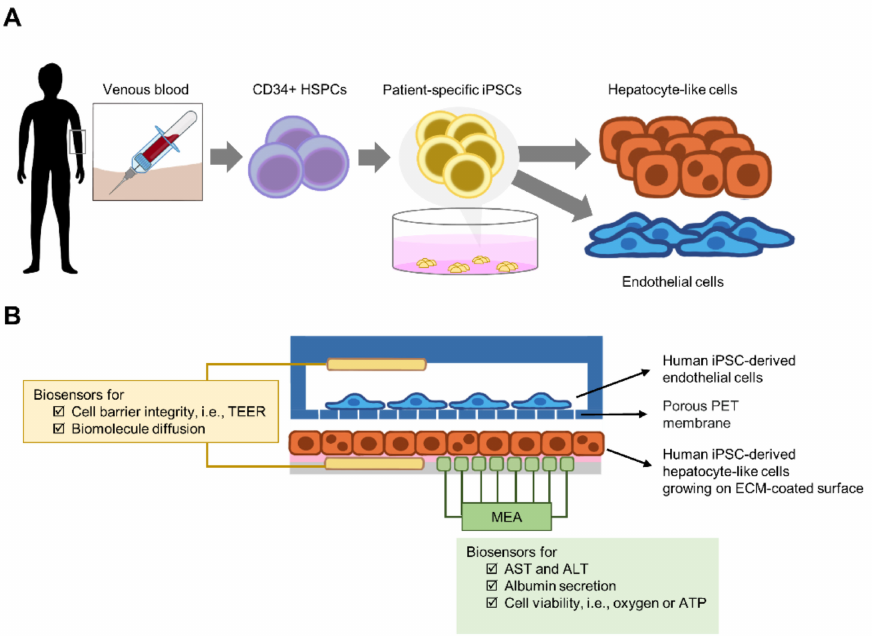
Figure 5. Proposed model for a liver-on-a-chip integrated with a biosensor. ( A ) Collection of CD34+ HSPCs from peripheral venous blood is less invasive than skin biopsy. The use of patient-specific iPS cells is a promising approach to generate individualized hepatocytes and endothelial cells. Moreover, the expandability of iPSCs provides an unlimited supply of patient-specific cells of interest for the liver-on-a-chip. ( B ) Proposed liver-on-chip model. The microarchitecture is similar to that in Figure 3D, except that no monocytic cells or hepatic stellate cells were used. Endothelial cells grew on the porous PET membrane, while human primary hepatocytes grew on the fibronectin-coated surface of the lower chamber. Based on the model proposed by Maoz et al. two different electrodes are placed at distinct positions. The transepithelial electrical resistance (TEER, yellow) electrode was inserted into the upper and lower chambers. Gap formation between endothelial cells causes a decrease in TEER. Thus, sinusoid integrity and other diffusing biomolecules can be examined. Moreover, a multielectrode array (MEA, green) can be inserted in the lower chamber to detect oxygen or other secreted molecules, i.e., AST, ALT or albumin. In addition, the MEA is able to measure morphology, growth and proliferation of cells. Thus, this proposed model is useful for assessing the effects of barrier loss on hepatocyte viability or function. Abbreviations: PET, polyethylene terephthalate; ECM, extracellular